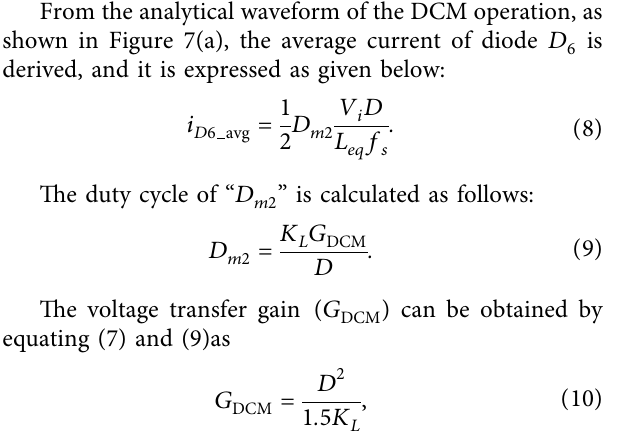
Figure 6: Equivalent circuit of the proposed converter in